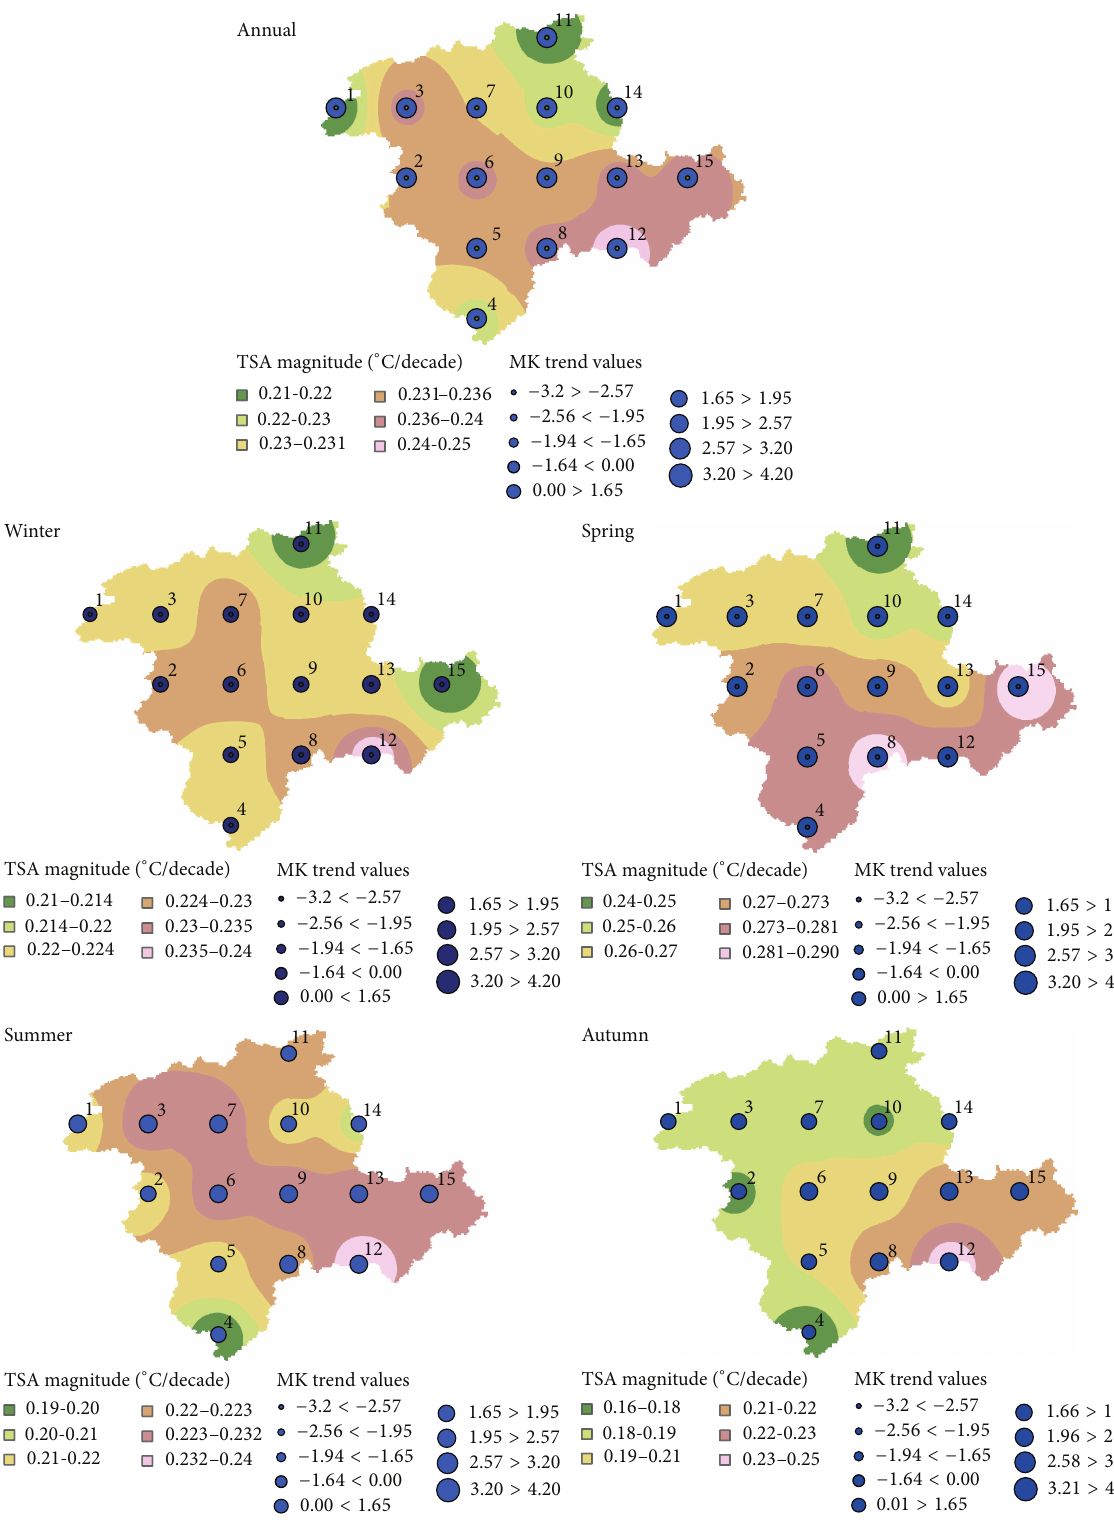
Figure 3: Spatial distribution of stations with MK test results and interpolated TSA magnitude ( ∘ C/decade) of annual and seasonal TMax data series over the period of